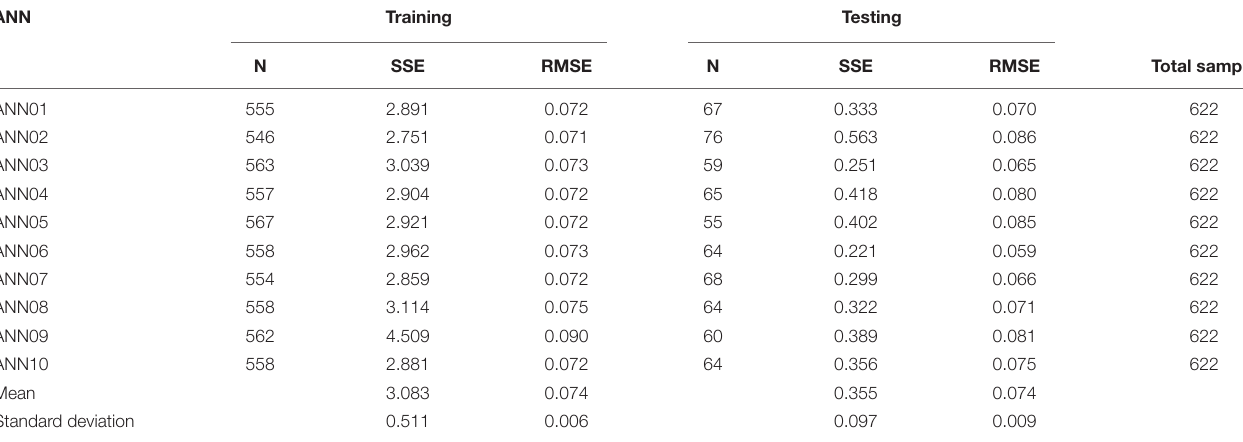
TABLE 6 | Root mean square error (RMSE) for artificial neural network model. ANN